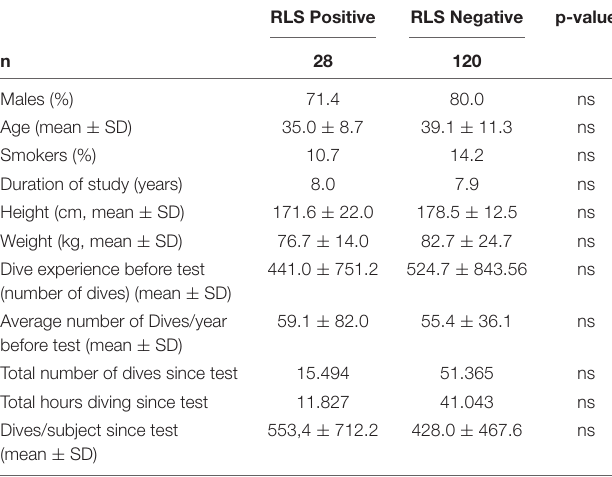
TABLE 1 | Biometry and dive experience.